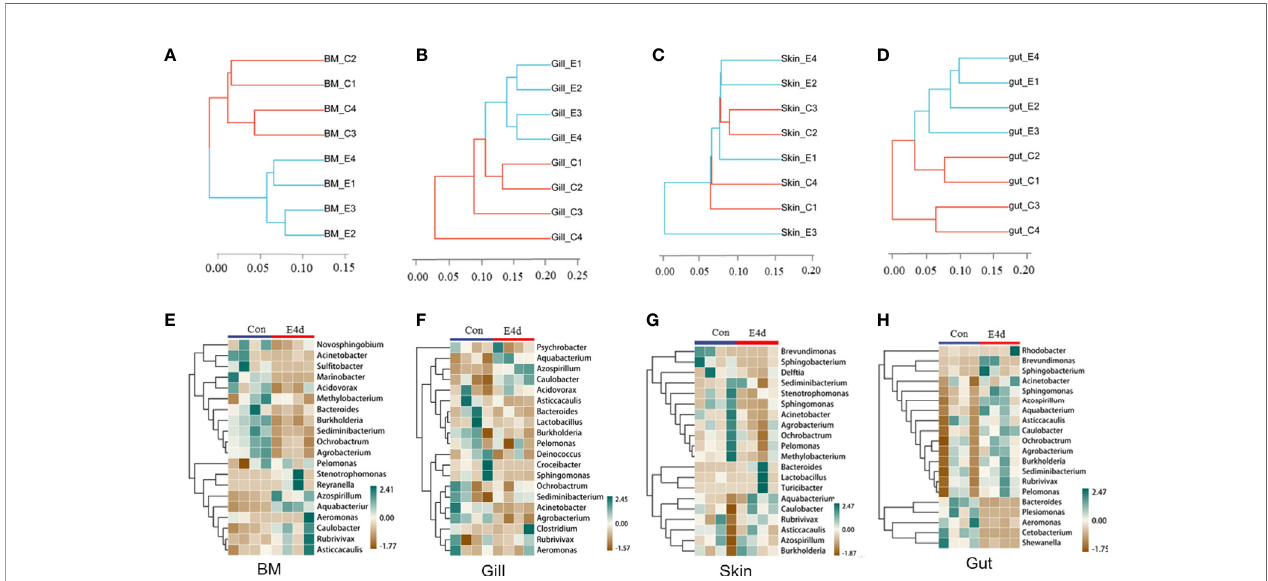
FIGURE 4 | The diversi fi cation of microbiota community at genus level in common carp mucosal tissues after SVCV infection. (A – D) Hierarchical cluster analysis of Weighted-unifrac distances generated from BM (A) , gills (B) , skin (C) , and gut (D) in control group and SVCV-challenged group. (E – H) Heat map showing the hierarchical clustering results for the abundance of bacterial genera in BM (E) , gills (F) , skin (G) , and gut (H) from SVCV-challenged and control fi sh. BM, buccal mucosa; E4d, 4 days after SVCV infection. Pheatmap package of R (version 3.4.4) was used to picture heat maps, Pearson correlation was carried out and Weighted-unifrac method was used to cluster the relative abundance values. The relative abundance values were scaled in